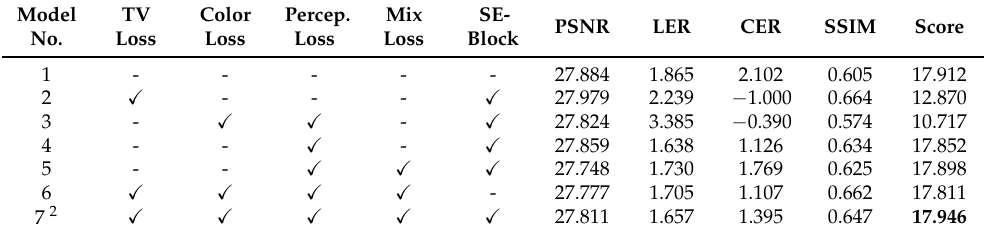
Table 4. Ablation study results on network architecture and loss functions 1 . Model